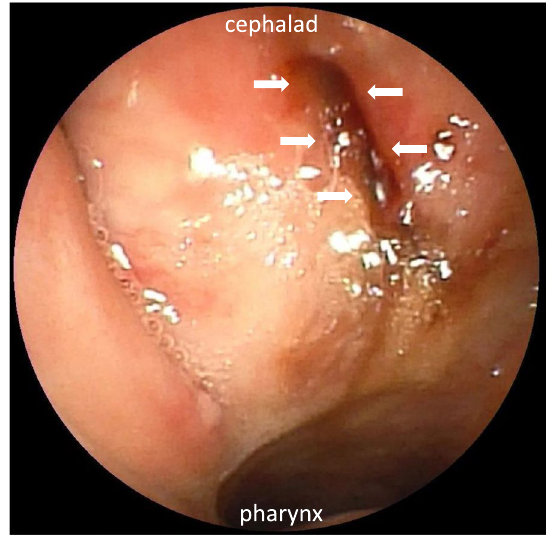
Fig. 2 A fiber-optic image of the nasopharynx taken by nasal endoscopy. A fresh laceration of the posterior pharyngeal mucosa was